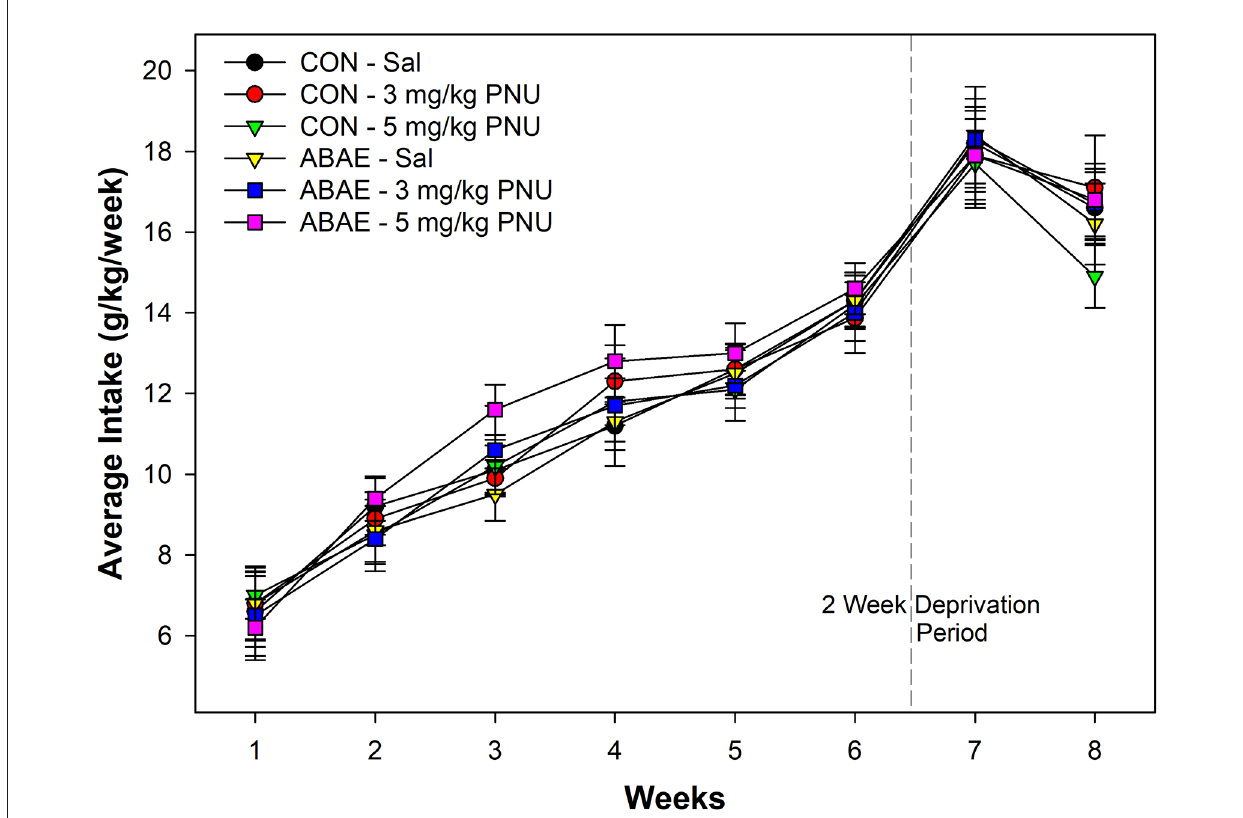
FIGURE5 Depicts the mean (+ SEM) weekly average intake (g/kg/day) of alcohol (beer) in male Wistar rats administered a subthreshold dose of EtOH during adolescence and the α 7 PAM PNU. There was a significant increase in alcohol consumption in all groups during the experiment, but not effects of ABAE or PNU